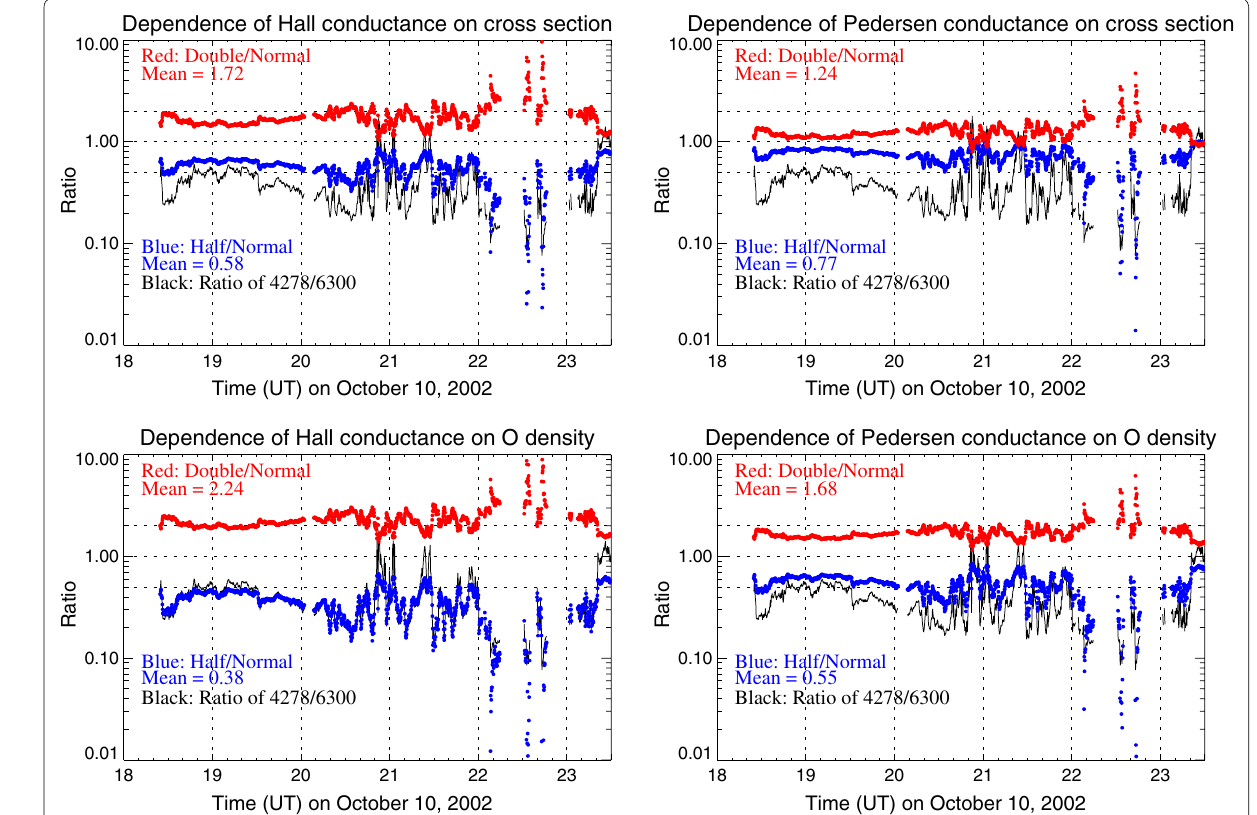
Fig. 17 Temporal variations of the ratios of height-integrated conductivities for October 10, 2002; temporal variations of ratios of height-integrated Hall ( left ) and Pedersen ( right ) conductivities as well as intensity ratios of 427.8 to 630 nm for October 10, 2002. Upper panels : Red and blue circles denote the ratios of values when the cross-sectional values are doubled or halved to the normal values, respectively. Lower panels : same to the upper panels but for atomic oxygen